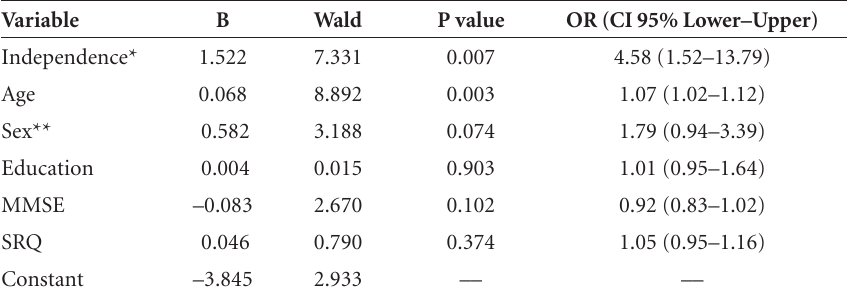
Table 4. Variables kept in the final model of the logistic regression: prediction of global mortality.